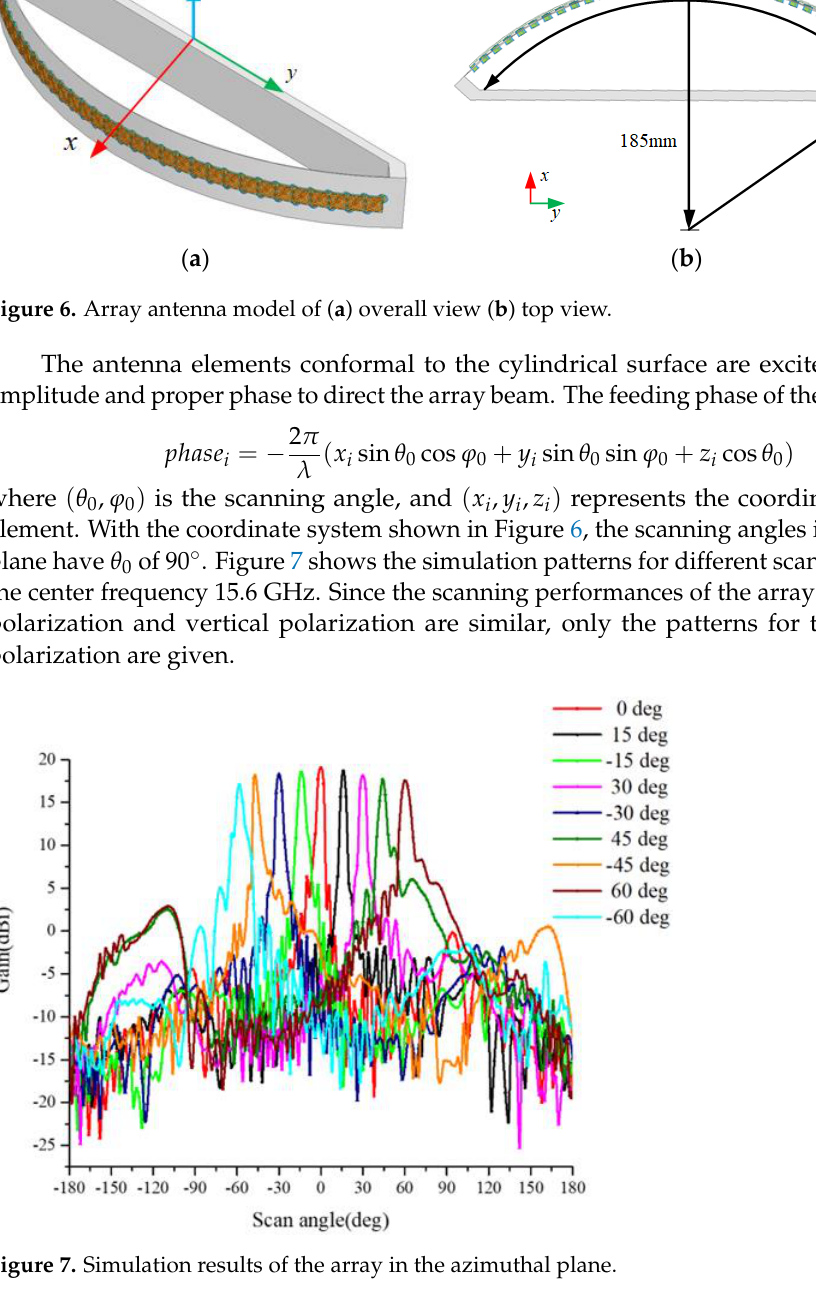
Figure 7. Simulation results of the array in the azimuthal plane. It can be seen from the simulation results that when the scanning angle is 0 ◦ , the maximum gain is 19.06 dBi, and when the scanning angle is − 60 ◦ , the gain is17.05 dBi.